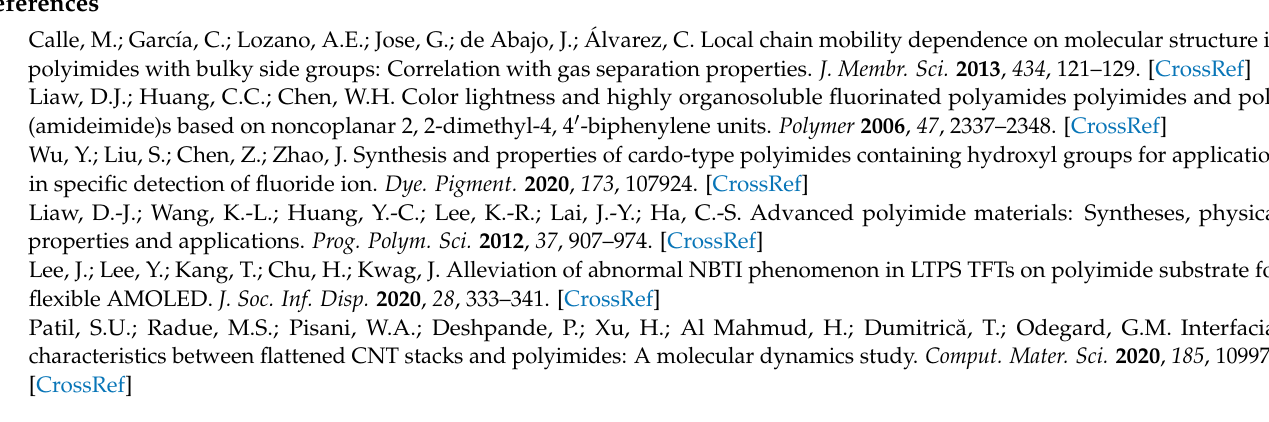
Figure S4: MS spectrum of m-DABA. Figure S5: FT-IR spectra of m-DABN, m-DABA and m-DABPI. Figure S6: TGA (a), DMA (b) and TMA (c) curve of m-DABPI film. Figure S7: Photo image of the flexible m-DABPI film. Figure S8: Displacement of O 2 and H 2 O from their initial positions in DABPI and